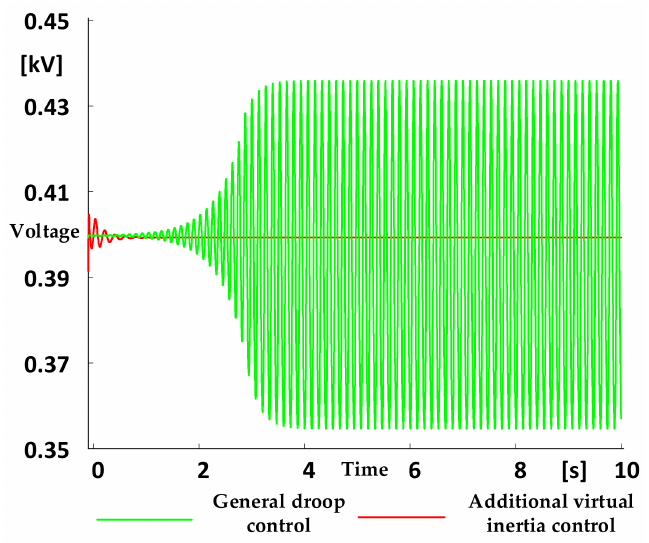
Figure 7. Voltage waveform with or without virtual inertia